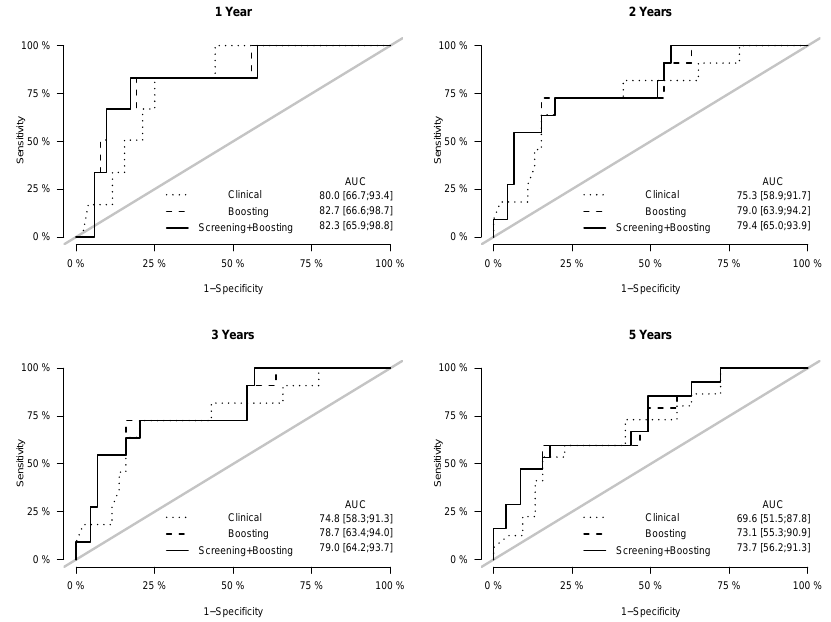
Figure 3. ROC curves and assocaited AUC values of the cumulative incidence predicted by the competing models on the testing data, at years 1, 2, 3 and